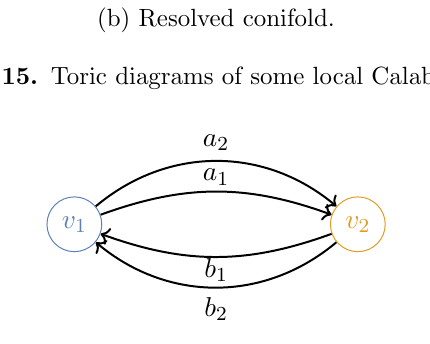
Figure 16. Quiver corresponding to the conifold